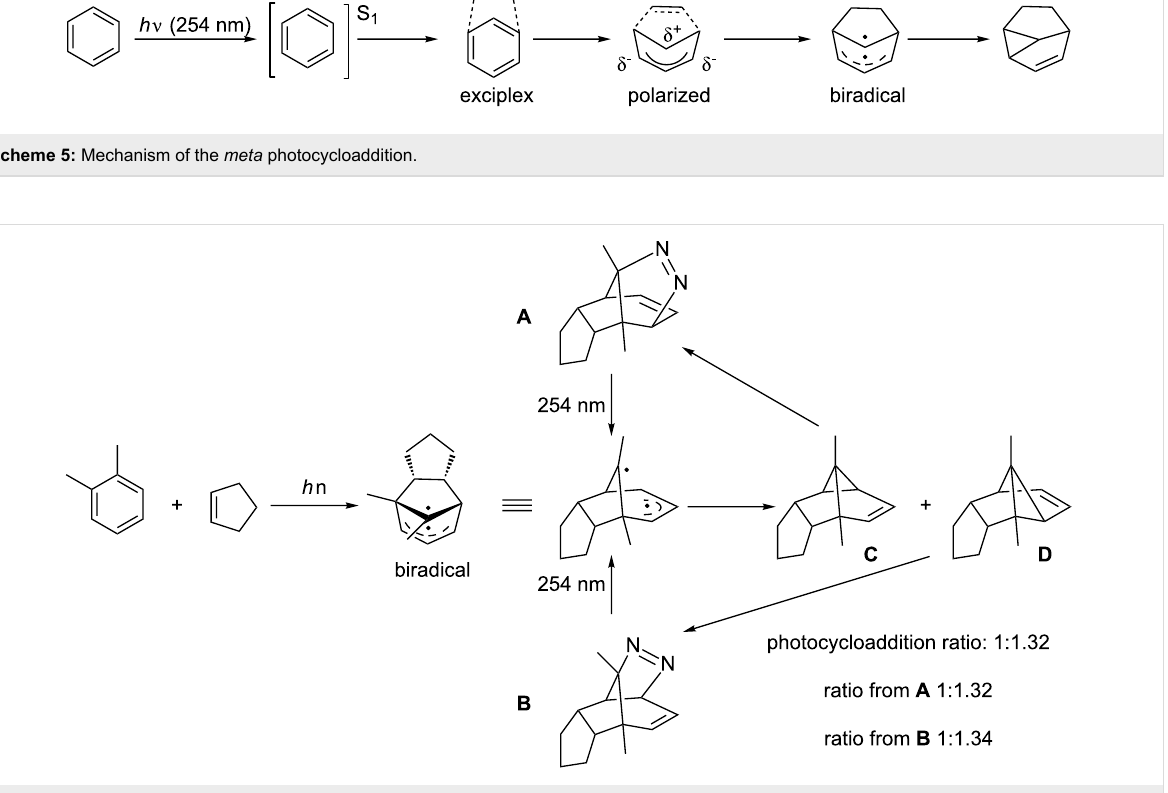
Scheme 6: Evidence of biradiacal involved in meta photocycloaddition by Reedich and